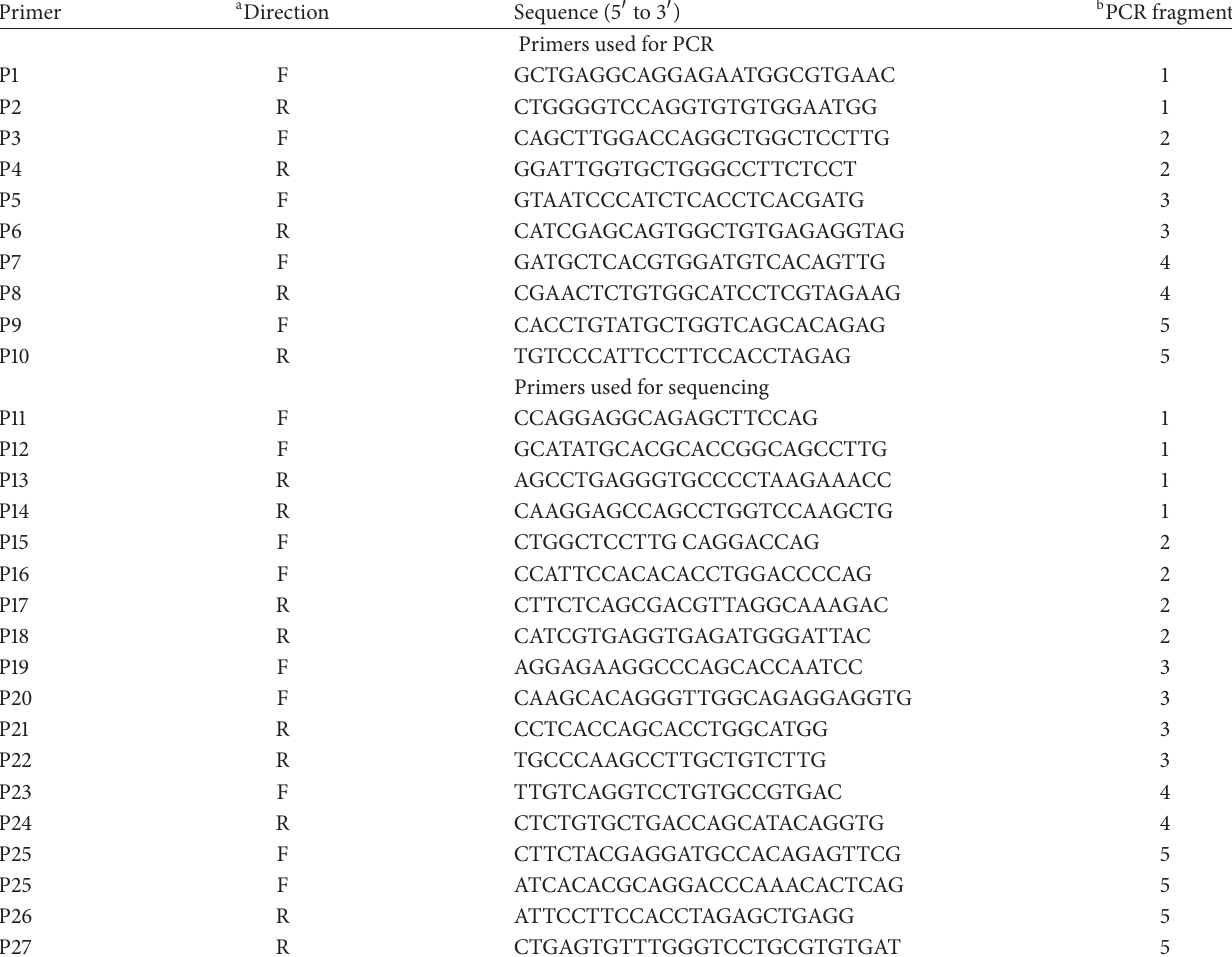
a F: forward primer; R: reverse primer. b PCR fragment denoted in Figure